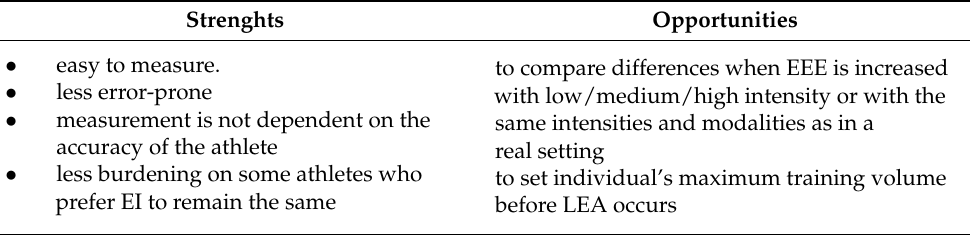
Table 1. SWOT analysis of the high-EEE protocol (SWOT = Strength, Weakness, Opportunity and Threat Analysis, EEE = exercise energy expenditure, EI = energy intake, LEA = low energy availability, EB = energy